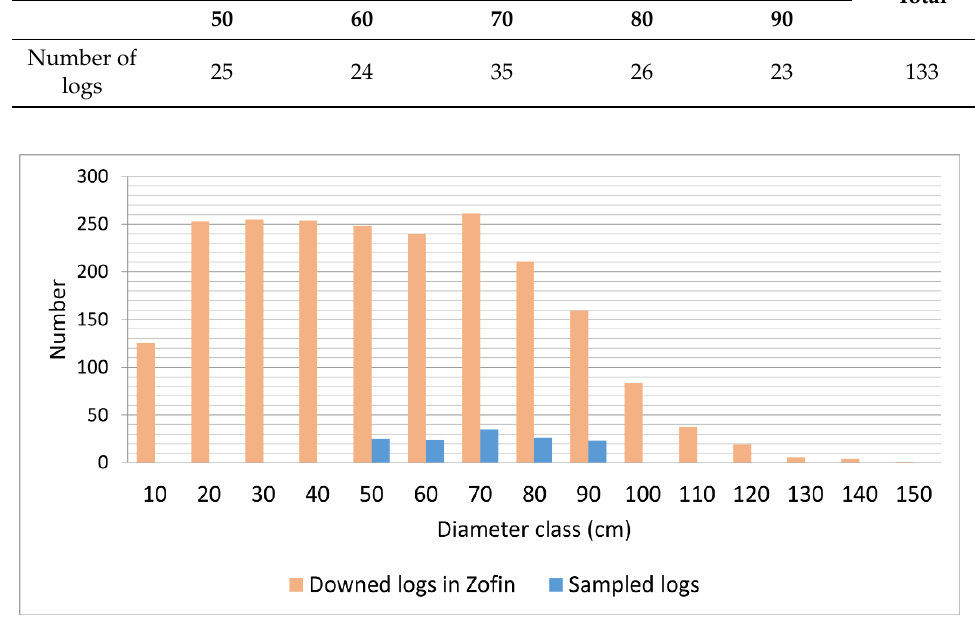
Figure A3. Diameter structure of downed deadwood in Zofin (25 ha) and sampled logs. Diameter classes are diameters of logs rounded to the nearest